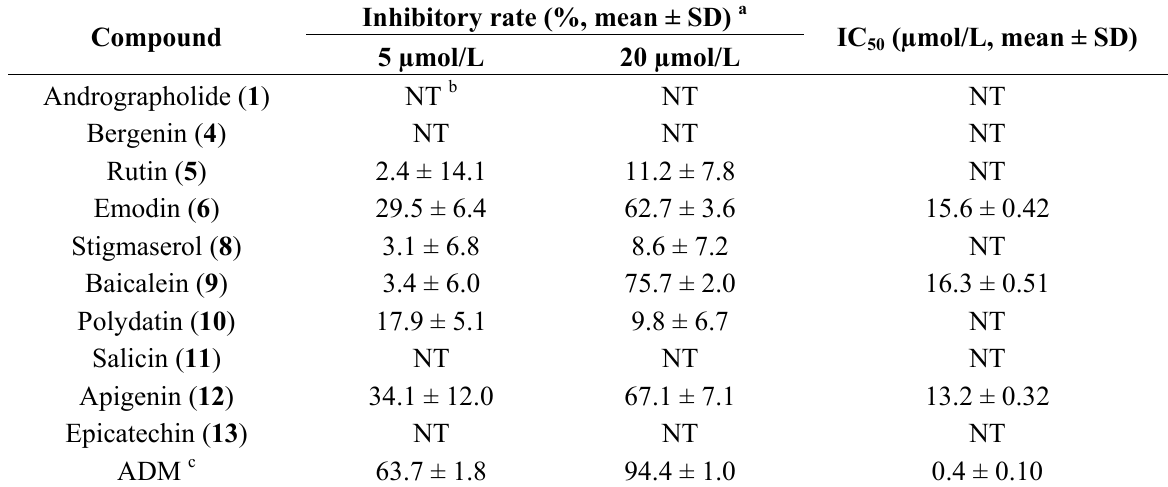
Table 1. Antitumor activities of the tested compounds from Caesalpinia decapetala (Roth) Alston on the growth of human gastric carcinoma cell line MGC-803 in vitro .